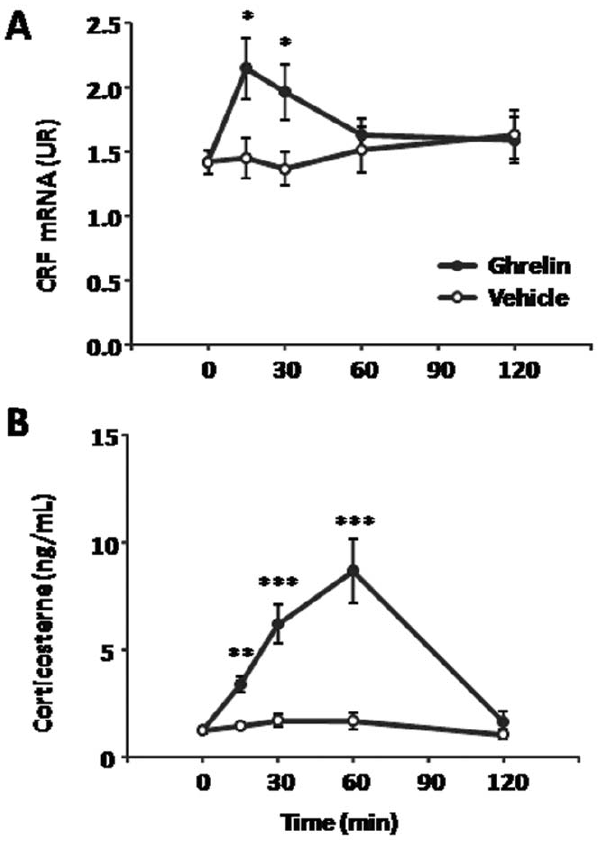
Figure 3. ICV ghrelin administration activates the HPA axis. Panel A shows comparative values of RT-qPCR for CRF mRNA in the PVN micro-dissected punches obtained from vehicle-treated and ghrelin- treated mice sacrificed at different time points. Data is shown as mRNA levels of CRF relative to the housekeeping gene Cyclophilin A, calculated by the comparative threshold cycle (Ct) method. Panel B shows comparative values of specific ELISA for plasma corticosterone obtained from vehicle- and ghrelin-treated mice sacrificed at different time points. Data represent the mean 6 SEM. *p # 0.05. **p # 0.01. ***p #